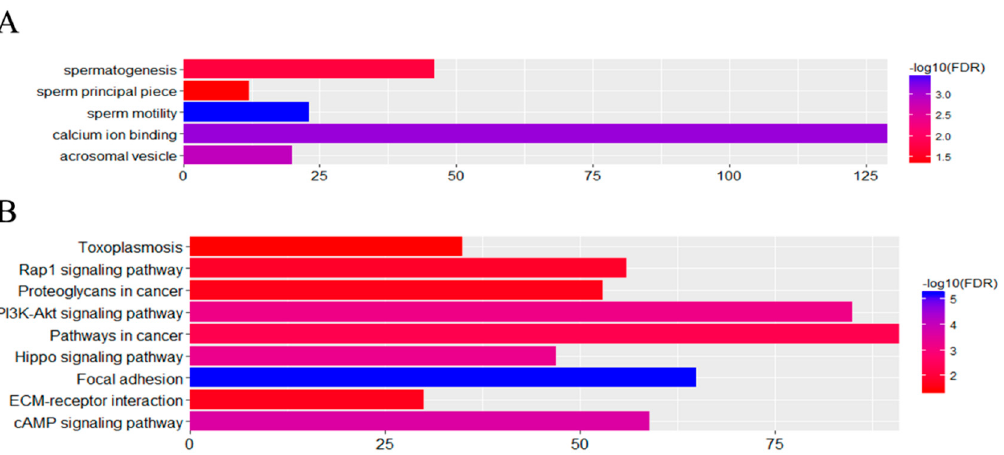
Figure 7. Distribution of the GO and KEGG categories assigned to the DEGs in groups 2 and 3. ( A ) GO terms assigned to 4162 DEGs. ( B ) Eight KEGG pathways assigned to 4162 DEGs.